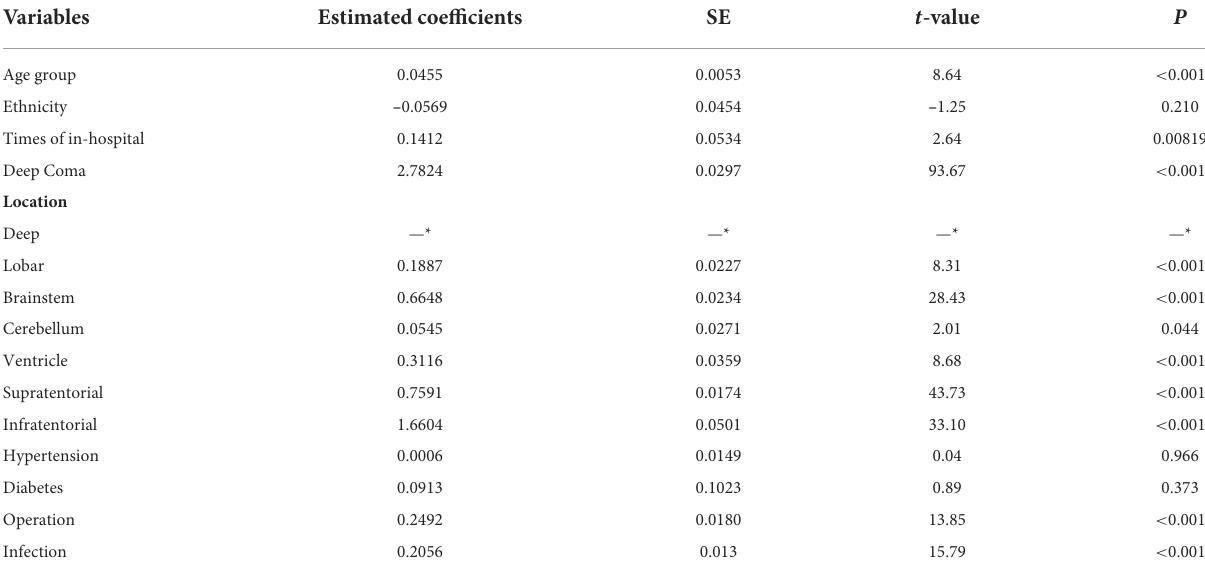
TABLE 4 The effect of each candidate variable on the SICH outcome at the 90-day post-discharge.